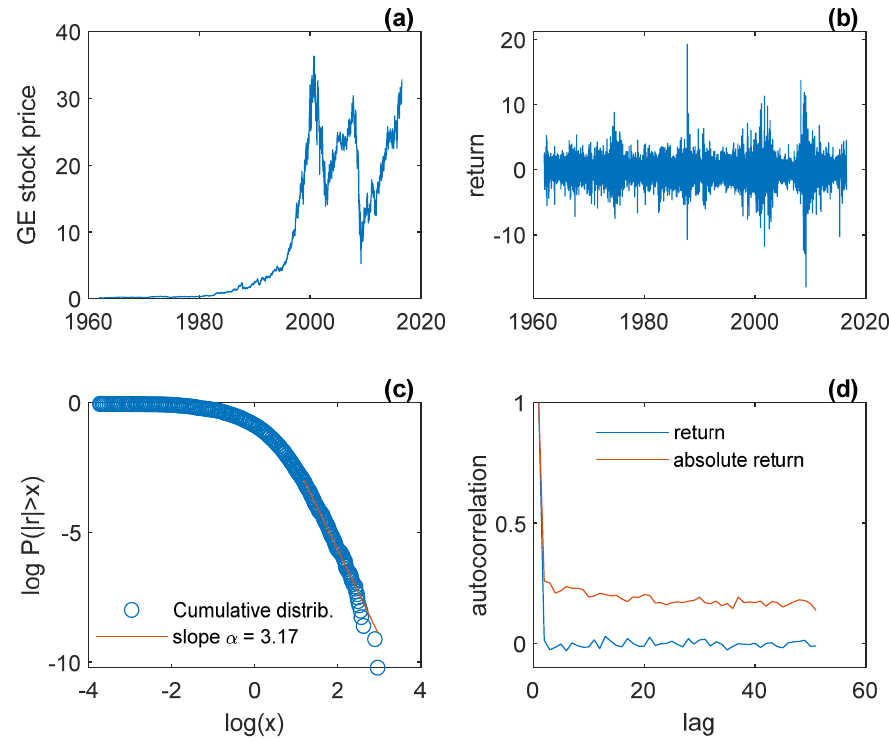
Figure 1. General Electric stock: ( a ) price; ( b ) return (in percent); ( c ) cumulative distribution of volatility in log-log scale, and a linear fit of the tail, with a slope close to 3; ( d ) autocorrelation function of return, which is almost zero at all lags, while that of volatility is nonzero over a long range of lags (a phenomenon known as volatility clustering).